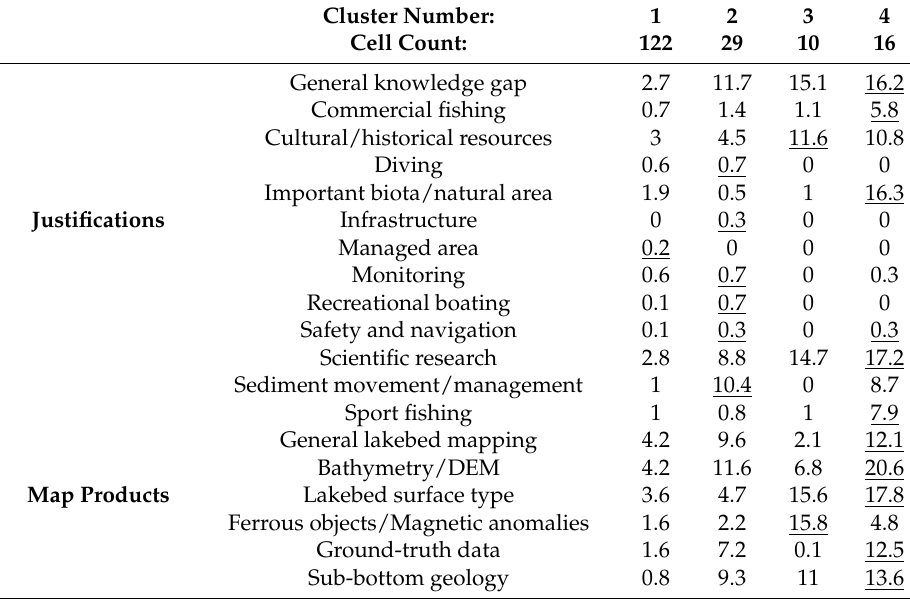
Table 3. Cluster analysis of cells based on the number of coins assigned under each Justification and Map Product. Mean number of coins associated with each Justification or Map Product among cells in each cluster is given. The highest value in each row is underlined. Results are reported using the groupings and values derived from unstandardized data and distance characterized using the Ward’s minimum variance algorithm (JMP v12), which yielded results that were representative of several